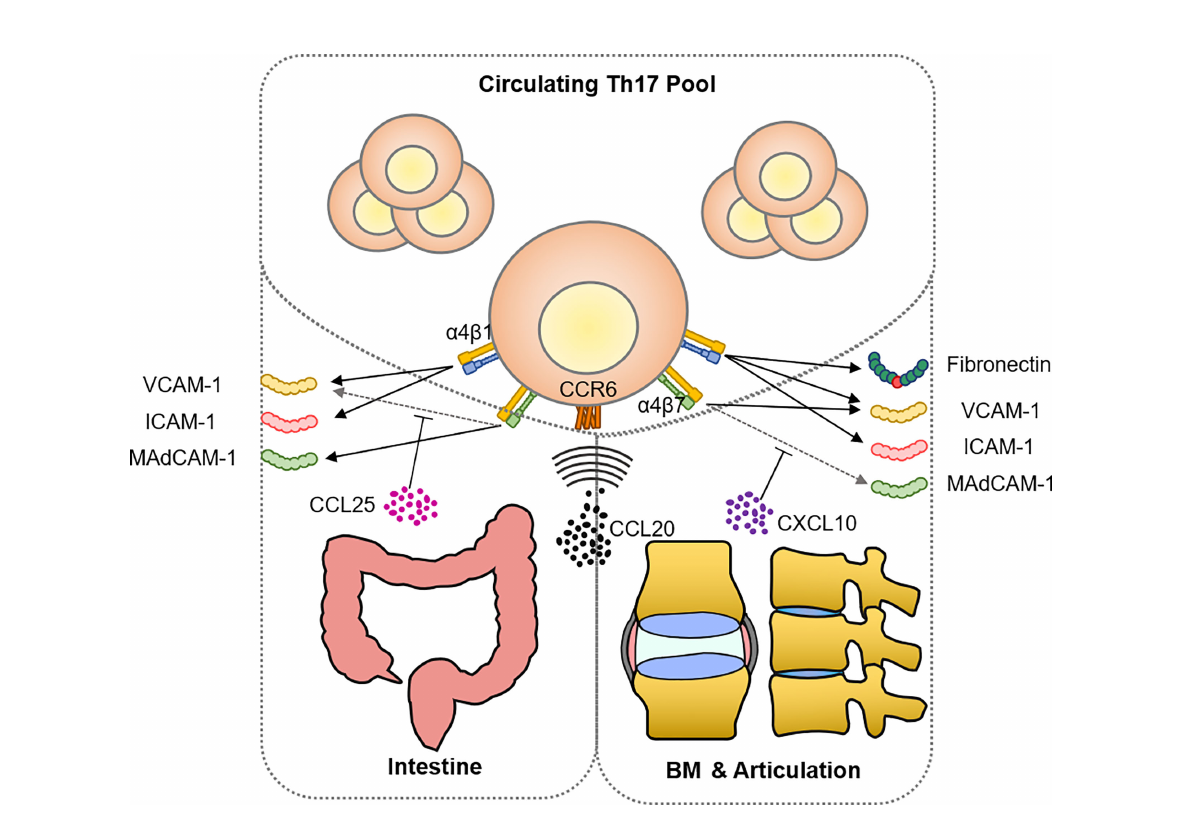
FIGURE 3 Shared mechanism of recruitment between intestine and articulation in AS. The ligand-receptor pair CCL20-CCR6 constitutes the predominant chemoattraction route of Th17 targeting both intestine and in fl amed articulation. Emerging evidence has shown that both tissues express compatible adhesion molecules including VCAM-1, ICAM-1, and MAdCAM-1 for integrin binding, allowing Th17 cells to enter the in fl ammatory site. Mechanical stress remodeled ECM provides not only T cell stimulant, as the aforementioned hyaluronan and collagen fragment, but also fi bronectin fragments that are able to bind and stimulate Th17 cells via integrin a 4 b